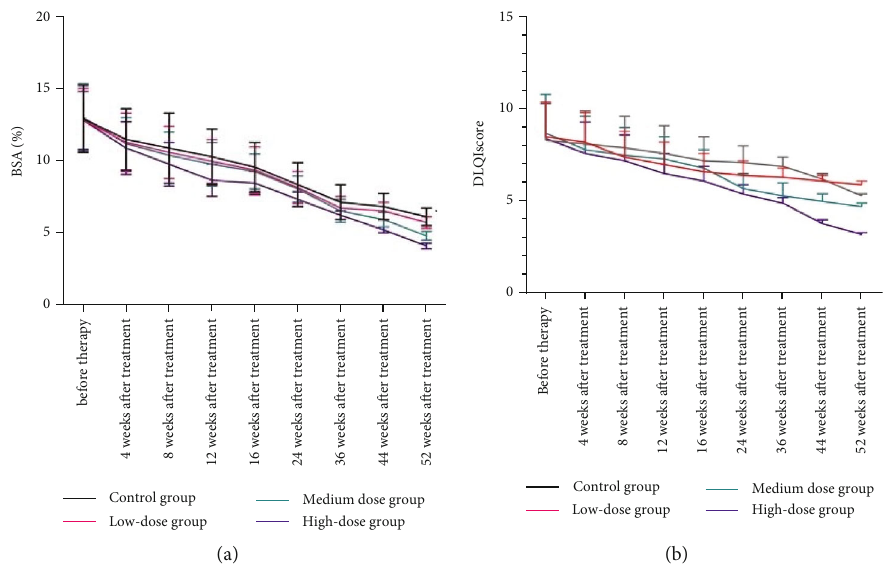
Figure 2: Comparison of the BSA and DLQI scores with four